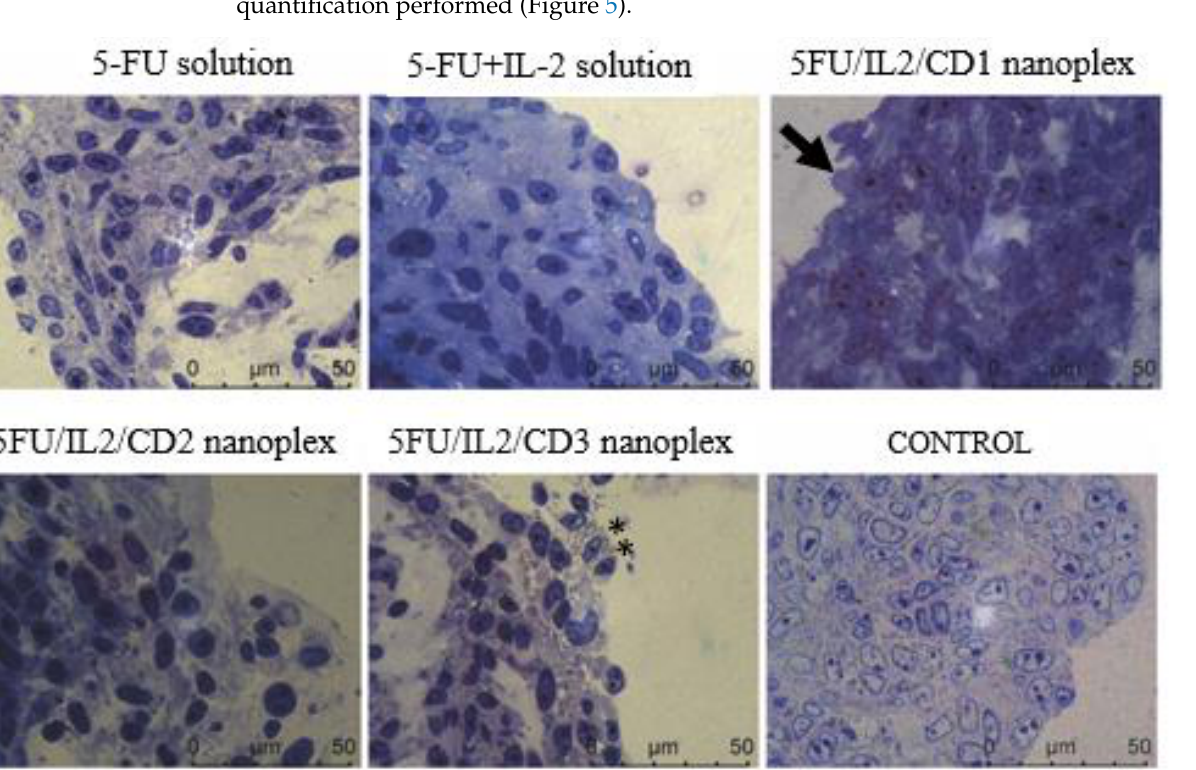
Figure 5. Representative micrographs of semi-thin section samples taken from the spheroids of the formulation and control groups; cells losing their integrity (**), cells undergoing apoptosis ( ↘ ).